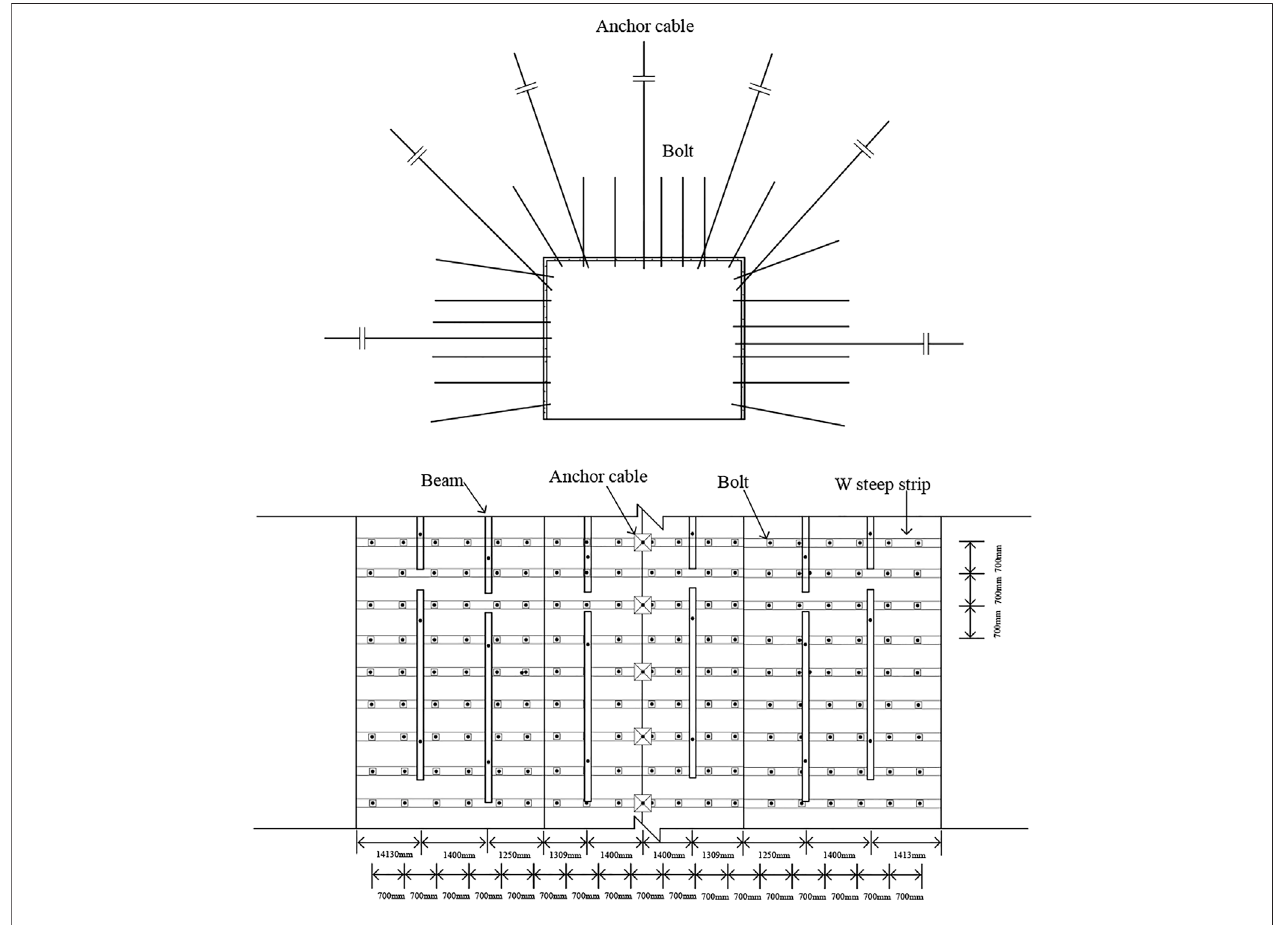
FIGURE 12 | Improved support